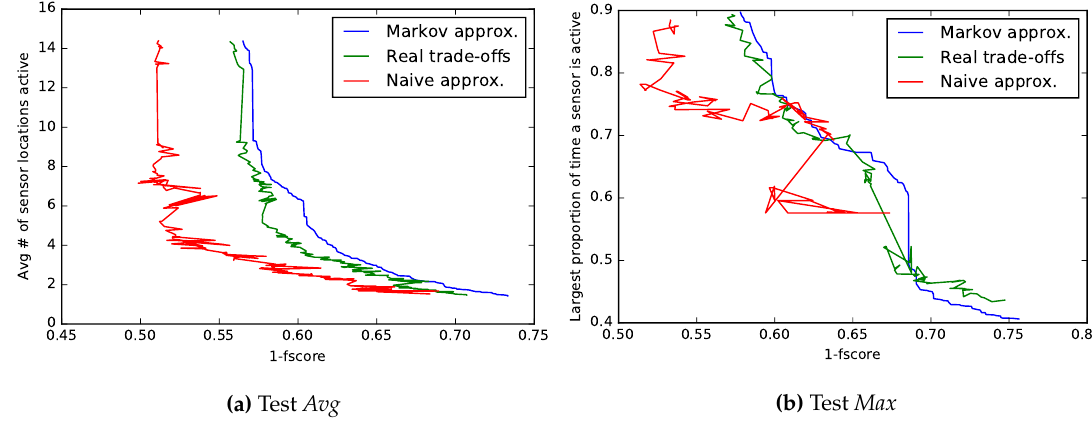
Figure 4. Non-dominated set of assignments evaluated in two Opportunity experiments. Both minimized F-score and an energy metric: on the left, the average number of active sensor locations is minimized; on the right, we minimize the proportion of time the most frequent sensor location is used. The blue line signifies the found non-dominated set using the Markov chain model. The same assignments were then tested with a real experiment (green) and with the naive model (red). Note that blue and red evaluations do not form a non-dominated set. The goal of the approximation is to be as close as possible to experimentally-achieved values (green); as in other datasets, the naive approximation is overly optimistic in almost all